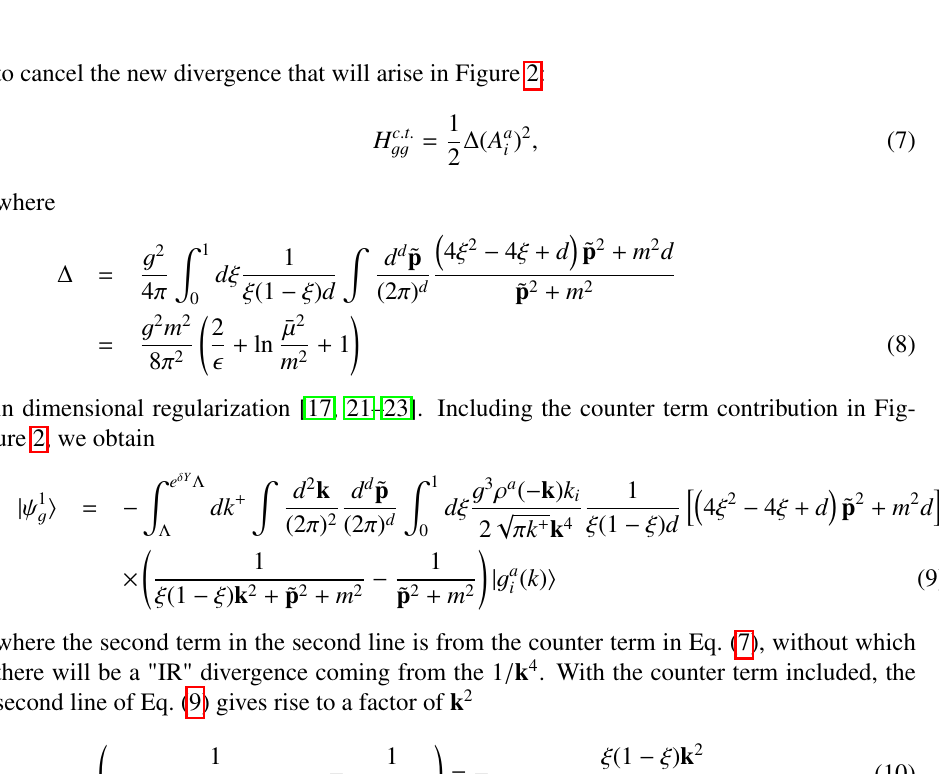
Figure 3. Quark emission diagrams, where ξ is the defined as ξ ≡ p + / k + . The horizontal thick lines are valence charge current. Diagram (A) corresponds to the interaction there point interaction H g qq , and (B) to the instantaneous quark pair emission from the vertex H qq -inst